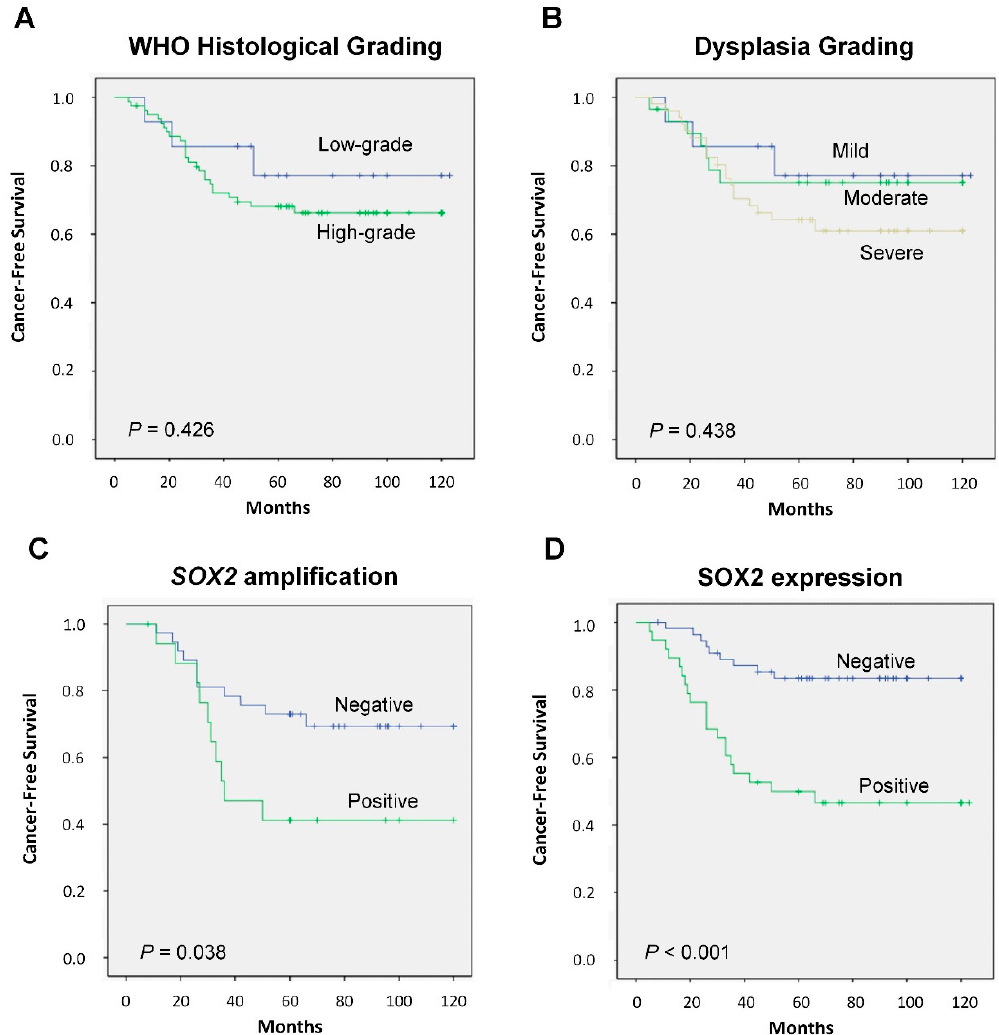
Figure 3. Kaplan-Meier cancer-free survival curves in the cohort of 94 patients with laryngeal dysplasias categorized by WHO (World Health Organization) histological grading ( A ), dysplasia grading ( B ) SOX2 gene amplification ( C ) or SOX2 protein expression ( D ). p values were estimated using the log-rank test.